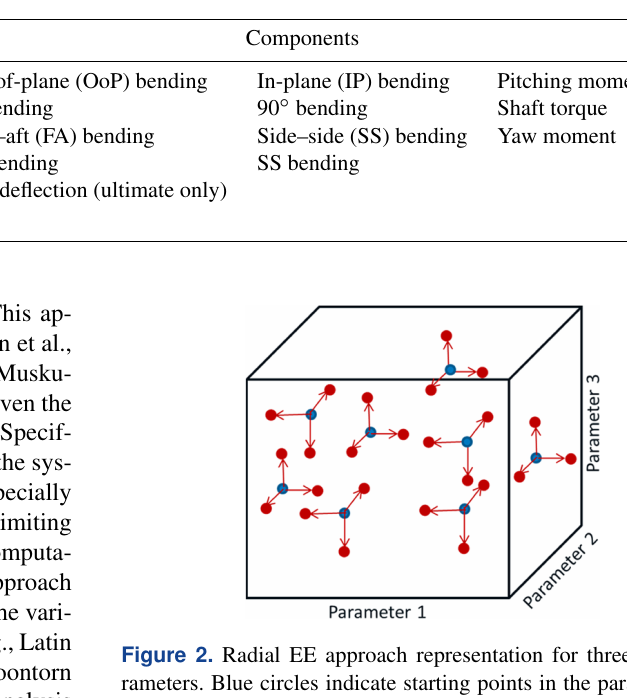
Table 1. Quantities of interest examined in the sensitivity analyses.